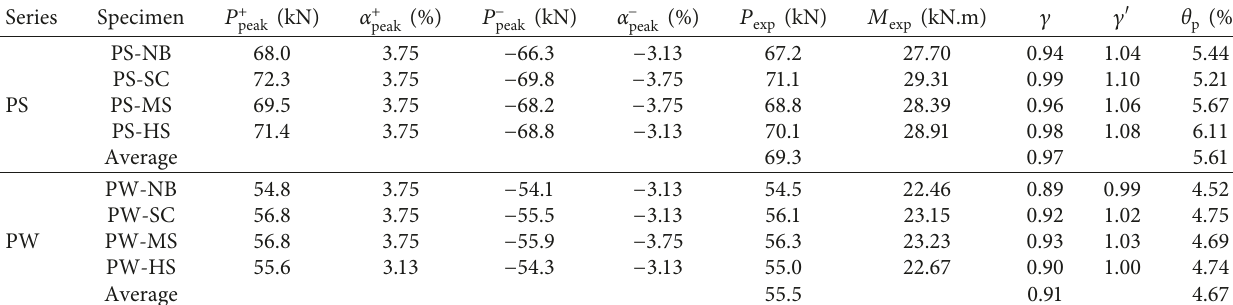
Table 3: Test result of test specimens.